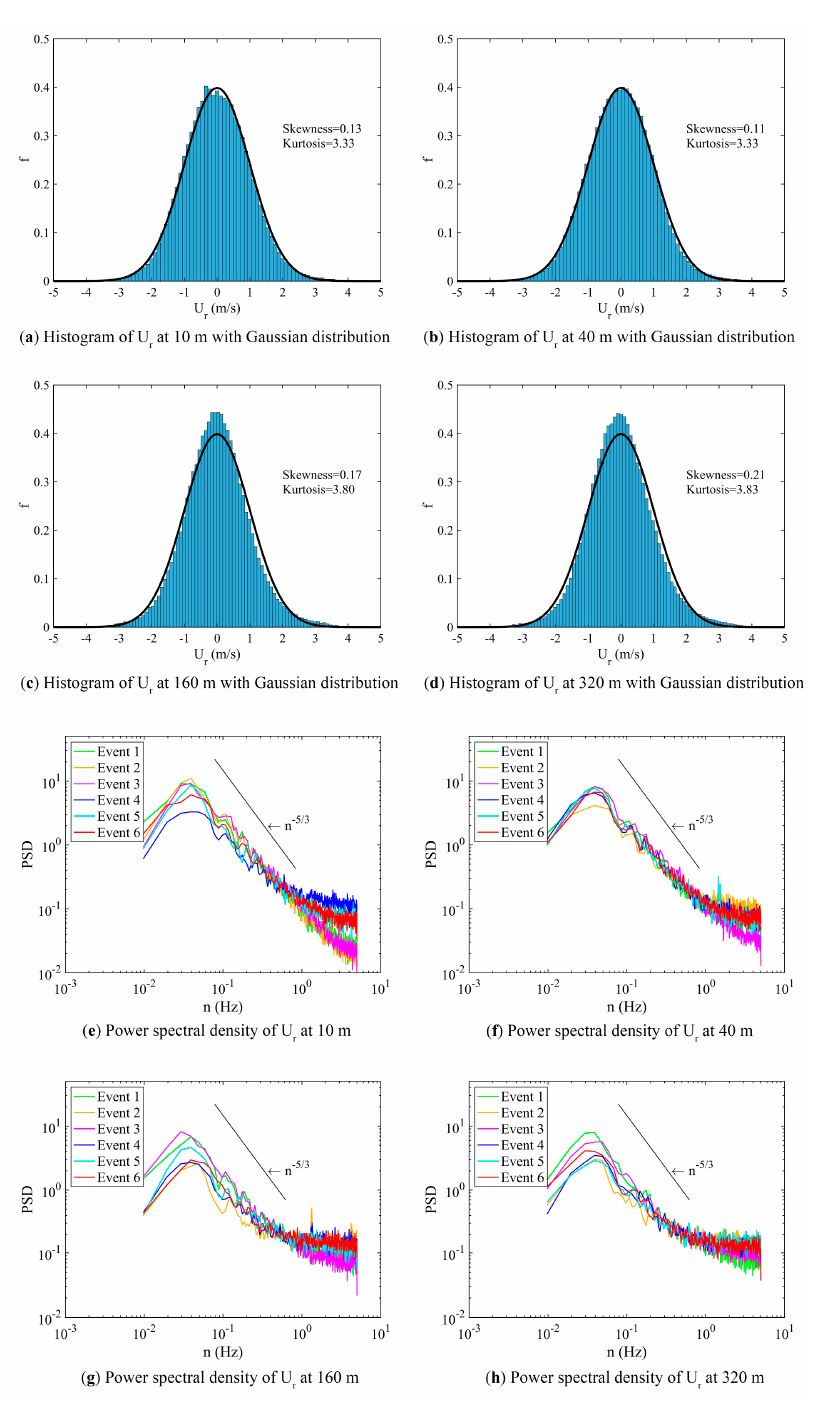
Figure 9. ( a – d ) Histograms of reduced turbulence fluctuation compared with Gaussian distribution, and ( e – h ) power spectral densities compared with − 5 / 3 law, at height levels of 10, 40, 160 and 320 m during 6 events.